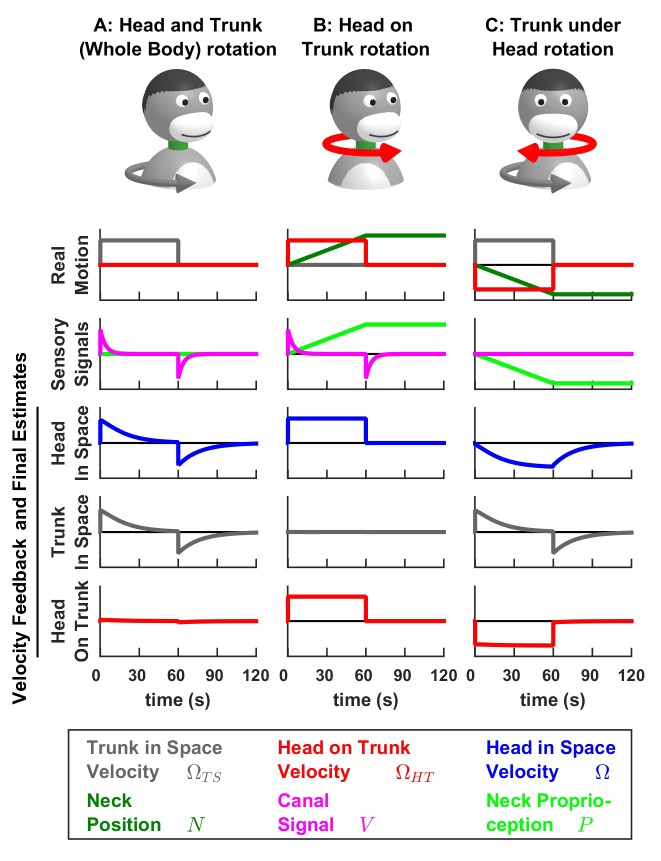
Long-duration passive head and trunk movements.The dynamics of head and trunk rotation perception during combined passive head and trunk movements were studied by (Mergner et al., 1991). Here, we reproduce the results of this study by simulating the same movements as in Figure 7 with a longer duration (60 s). The feedback signals about head in space velocity (third row, blue), trunk in space velocity (fourth row, gray) and head on trunk velocity (fifth row, red) are shown. During passive motion, this feedback is identical to the final motion estimate, and therefore, the curves in rows 3 to 5 also represent the perception of motion during these stimuli. A combined rotation of the head and trunk (A) activates the canals (magenta curve). Following the initial acceleration at t = 0, canal signals fade away with a time constant of 4 s. A canal aftereffect occurs following the deceleration at t = 60 s. The estimates of head in space and trunk in space velocity are identical to each other, and exhibit similar dynamics as the canal signal, although with a longer time constant of 16.5 s (for the same reasons as those described in Figure 4—figure supplement 1B). When rotating the head while the trunk is stationary (B), the simulated estimates of head in space (third row, blue) and head on trunk (fifth row, red) velocity persist indefinitely, as illustrated experimentally by Mergner et al. (1991). The difference in the time course of the signals in panels A and B is due to the additional presence of the neck proprioceptive signal. Strinkingly, during long duration rotation (C), the estimate of trunk in space velocity (fourth row, gray) decreases with an identical time constant as in (A), although the underlying sensory signals, that originate from the canals in A and from neck proprioception in C, have fundamentally different dynamics. Futher, the perception of trunk rotation is replaced by an illusion of head rotation (third row, blue) in an opposite direction. These model predictions exactly match experimental findings by Mergner et al. (1991).